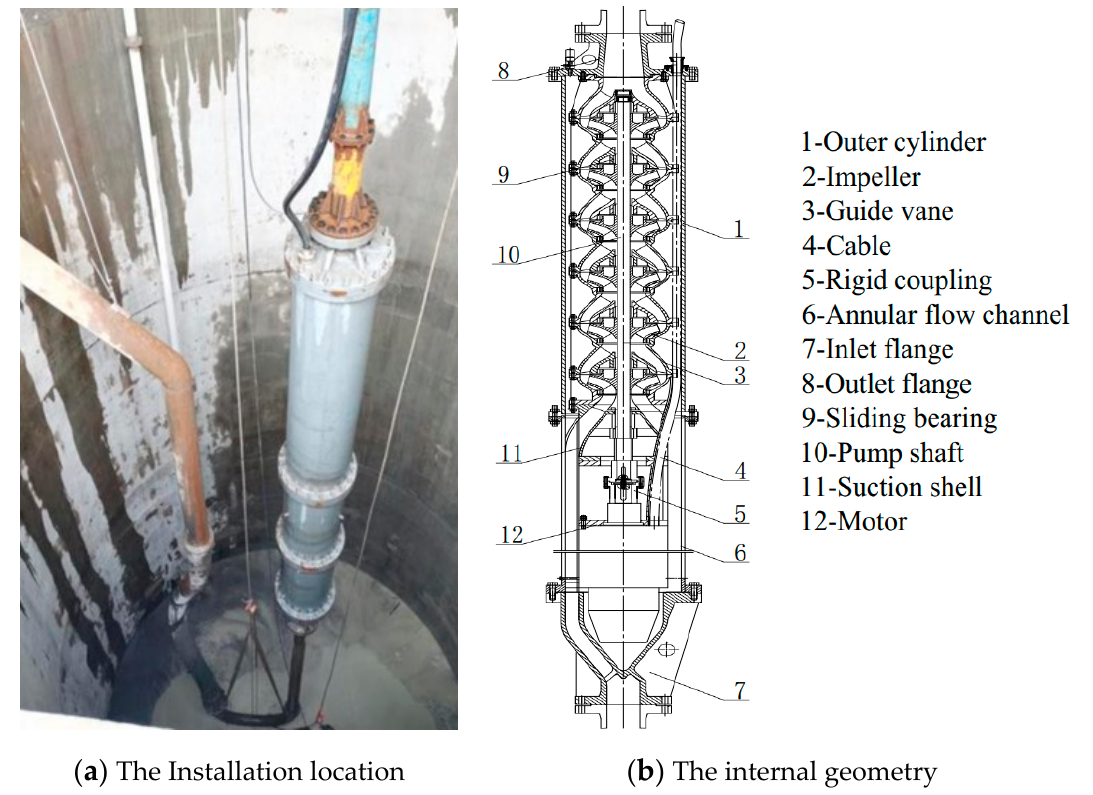
Figure 4. Deep-sea six-stage lifting motor pump. Table 1. The structure and hydraulic parameters of the six-stage lifting motor